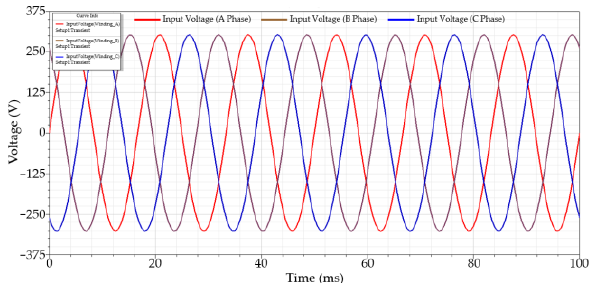
Figure 5. Simulation results of the winding voltage without a slow start.